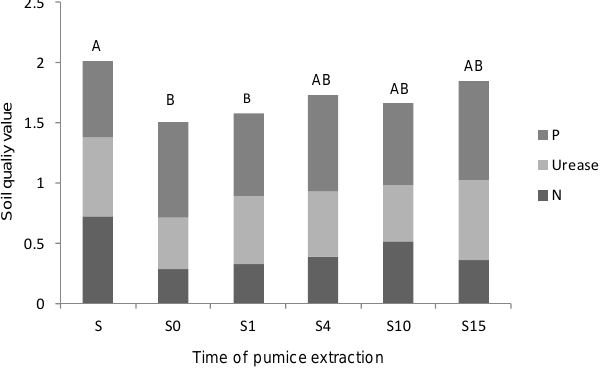
Figure 1. Additive soil quality index using linear scoring indica- tors chosen by principal component analysis and correlation analy- sis minimum data set (MDS)